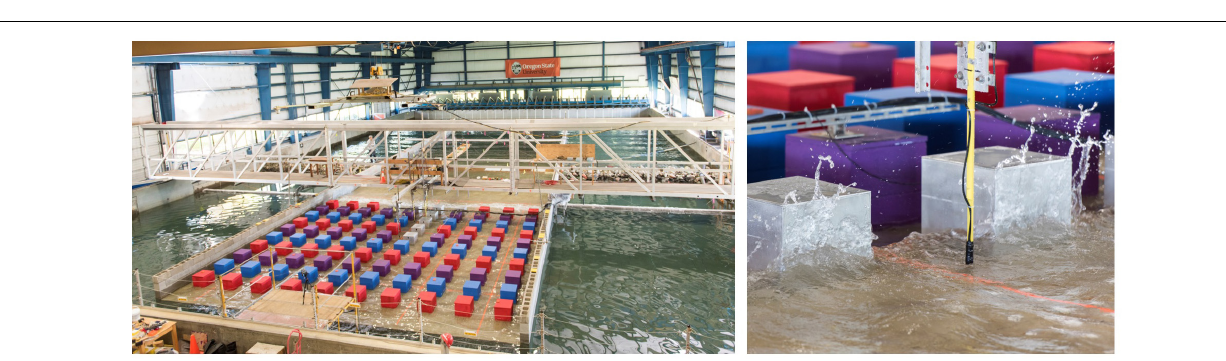
FIGURE 13 | Setup of overland flow in DWB (left) and detail of wave impact on coastal structures (right) .